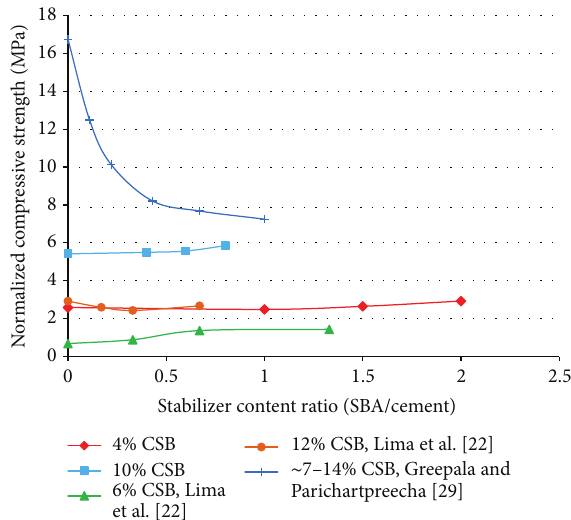
Figure6:Comparisonofcompressivestrengthofpresentstudywith earlier works [22, 29].